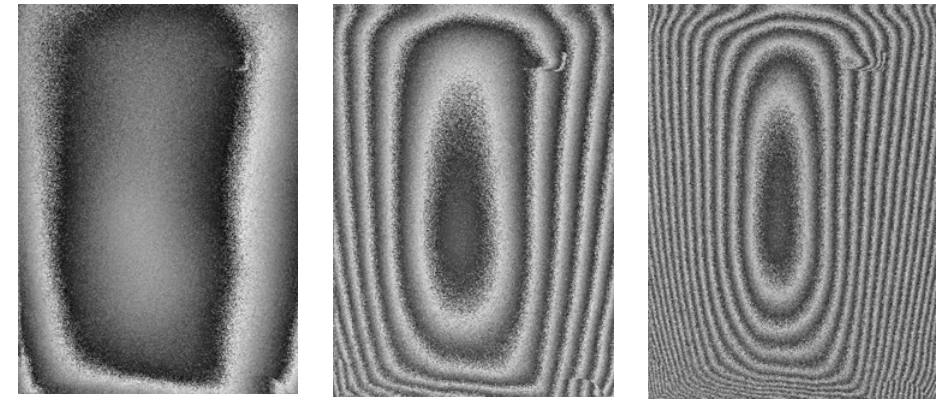
Figure 9. Wrapped interferograms recorded at (a, left) 8 sec, (b, centre) 120sec, (c, right) 180sec during unloading process.